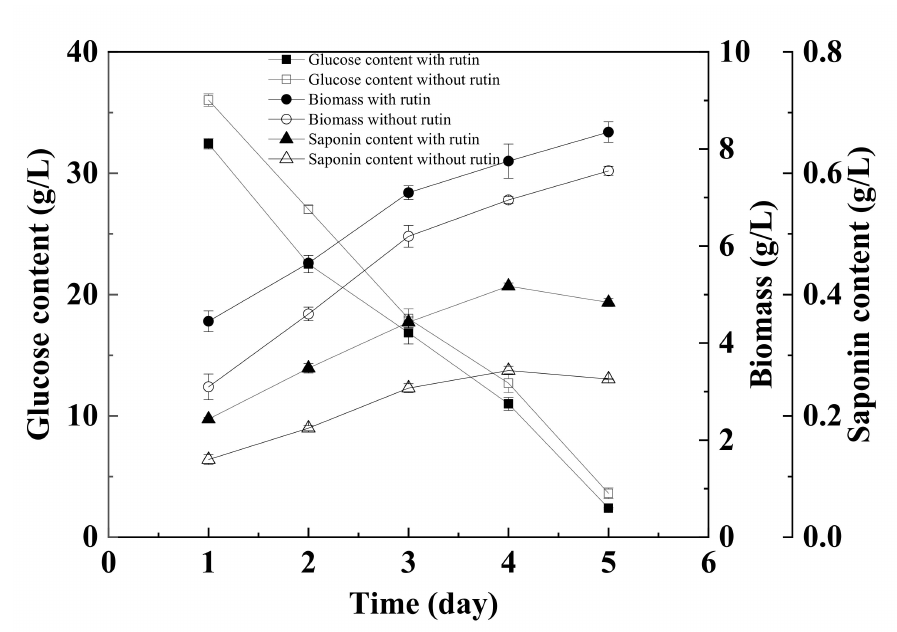
Figure 6. Time profiles of T. melanosporum fermentation under the optimized medium and culture conditions with and without